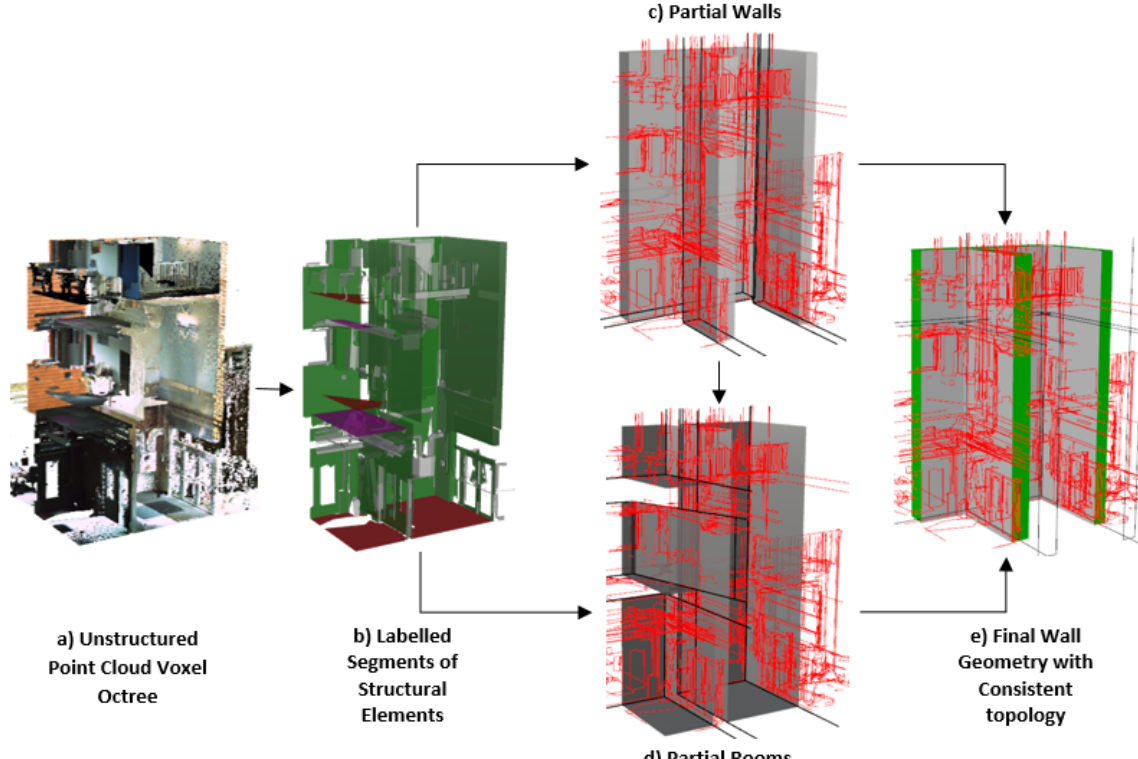
Figure 1: Overview general workflow wall reconstruction. Colorised point cloud (a), labelled planar primitives including walls, ceilings, floors, etc. (b), partial walls in grey and other geometry in red (c), partial rooms in grey and remaining geometry in red (d) and final walls in grey with green interior and remaining geometry in red